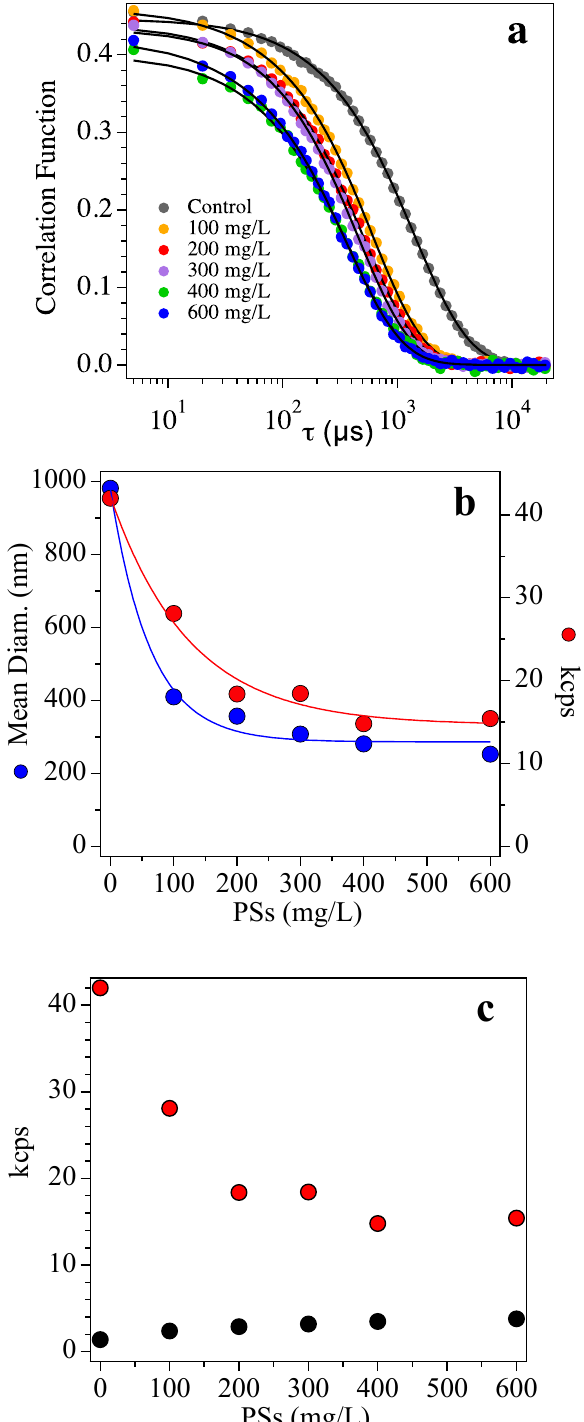
Figure 5. Panel ( a ): correlation functions of the heated samples (dots) along with the CONTIN fit (black lines) vs. the delay time ( τ ). Panel ( b ): mean diameters (blue) obtained from the fitting of the curves with the CONTIN algorithm together with the number of scattered photons (kilo counts per second (kcps), red). Lines are the best fit according to the exponential function reported in the text. Panel ( c ): comparison between the number of scattered photons in the heated (red) and not heated (black) samples.